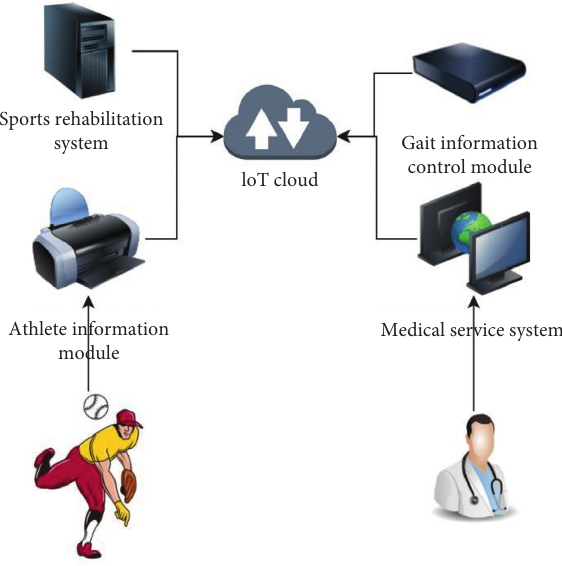
Figure 13: System function